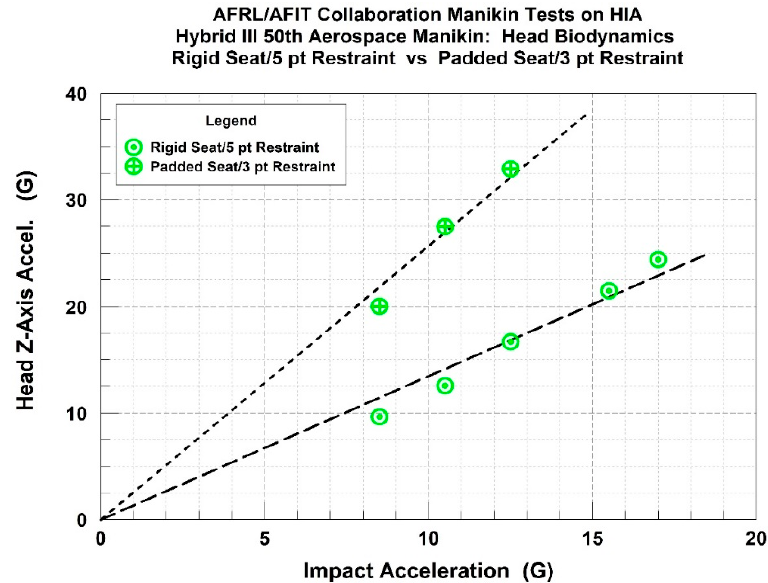
Figure 8. Comparison of head z-axis acceleration with different seats. The plot shows a comparison of the head z-axis acceleration from impacts with the rigid seat configuration compared to the head z -axis acceleration from impacts with padded seat configuration. The head accelerations with the padded seat are shown to be greater than with the rigid seat at all comparable impact accelerations.